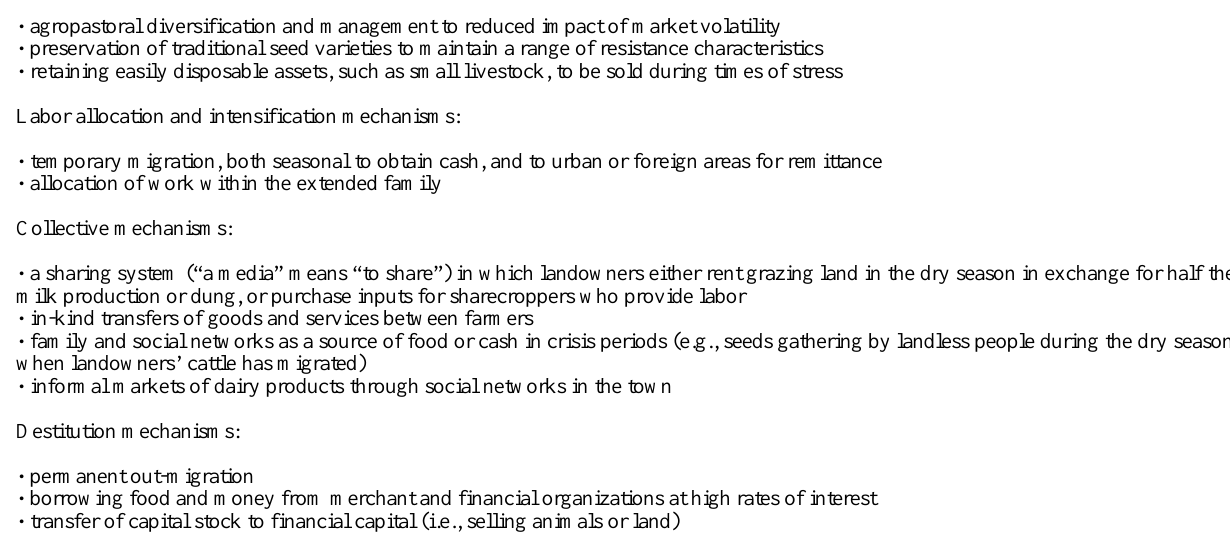
Table 2. Local mechanisms to cope with disturbance in the study